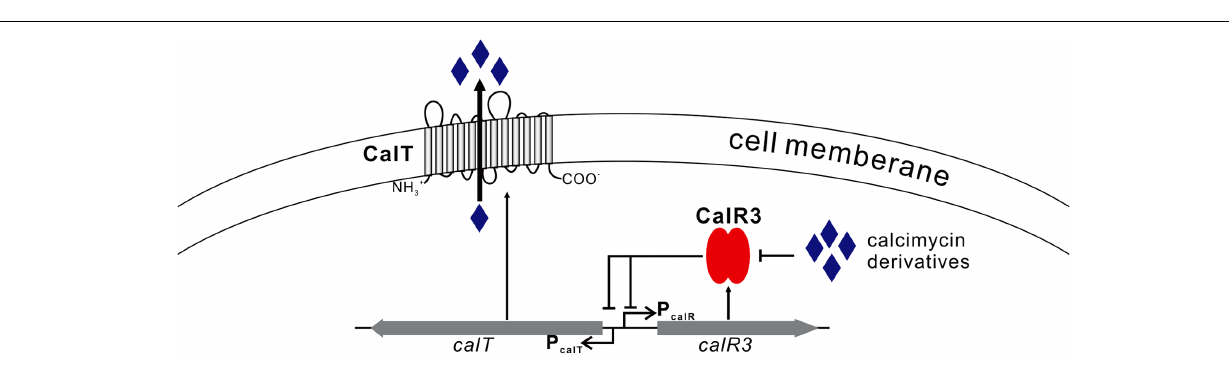
FIGURE 7 | Proposed model of CalR3-mediated regulation of calcimycin production in Streptomyces chartreusis NRRL 3882 Black arrows, activation; black bars,